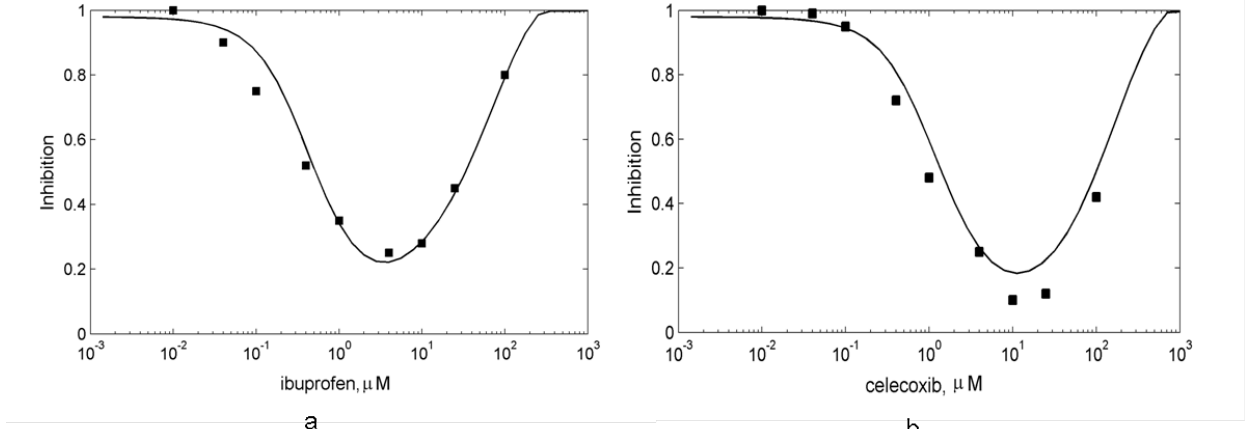
Figure 8. Effect of the suppression of aspirin-mediated inhibition of purified PGHS-1 by ibuprofen and celecoxib. The dose dependence of PGHS-1 inhibition by ibuprofen (a) and celecoxib (b) at the presence of 200 µ M aspirin. Lines—theoretical results, points— experimental data [8]. Inhibition of oxygen consumption by PGHS-1 is given in relative